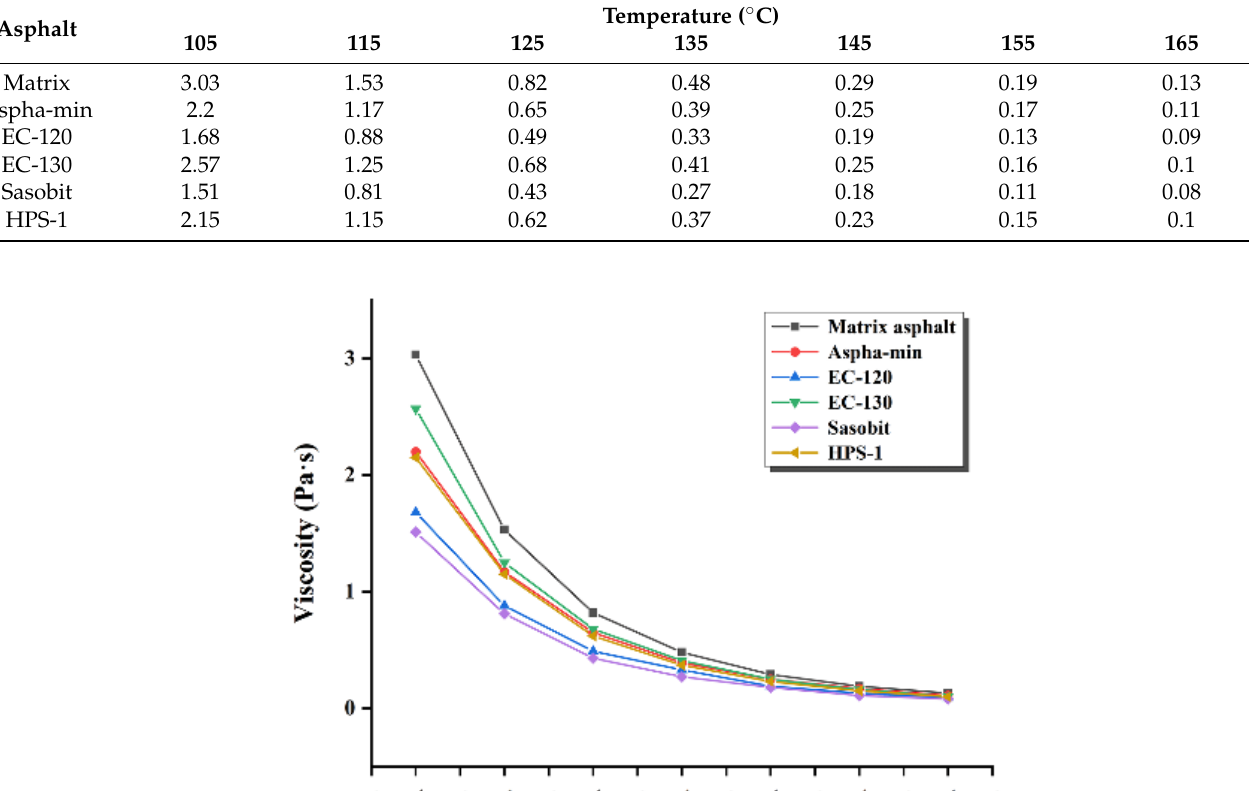
Table 8. Viscosity test results of different asphalts (Pa · s).